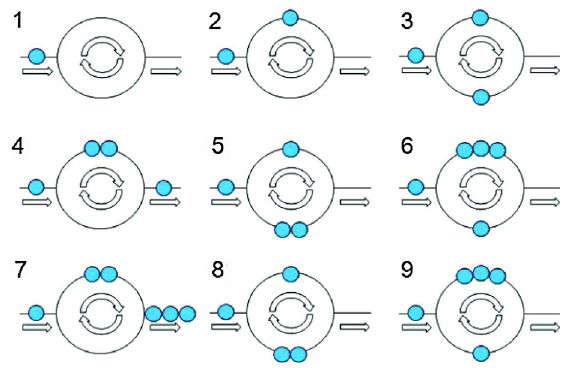
FIG. 8. Scheme of first several circulations in the first combiner ring. In step 4 the 1 GHz train is extracted without